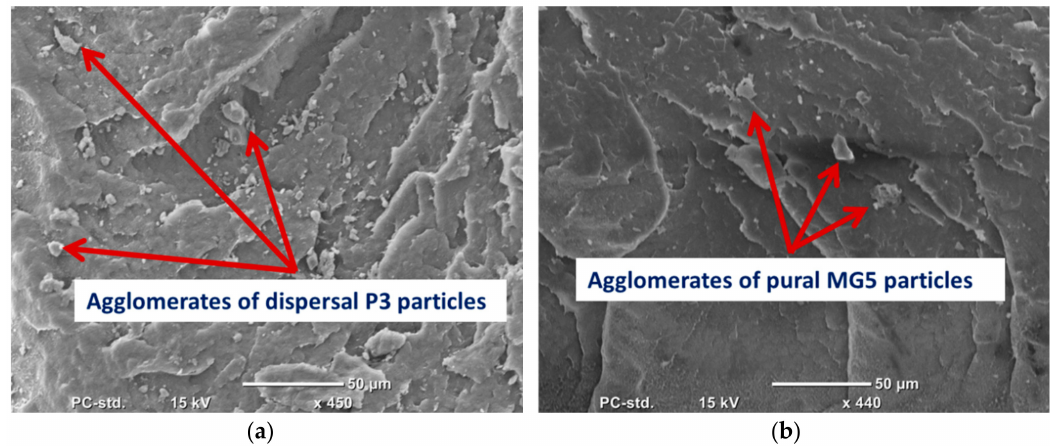
Figure 5. SEM micrographs of the cryo-fractured surfaces of ( a ) HDPE-10%P3 and ( b ) HDPE-10%MG5.